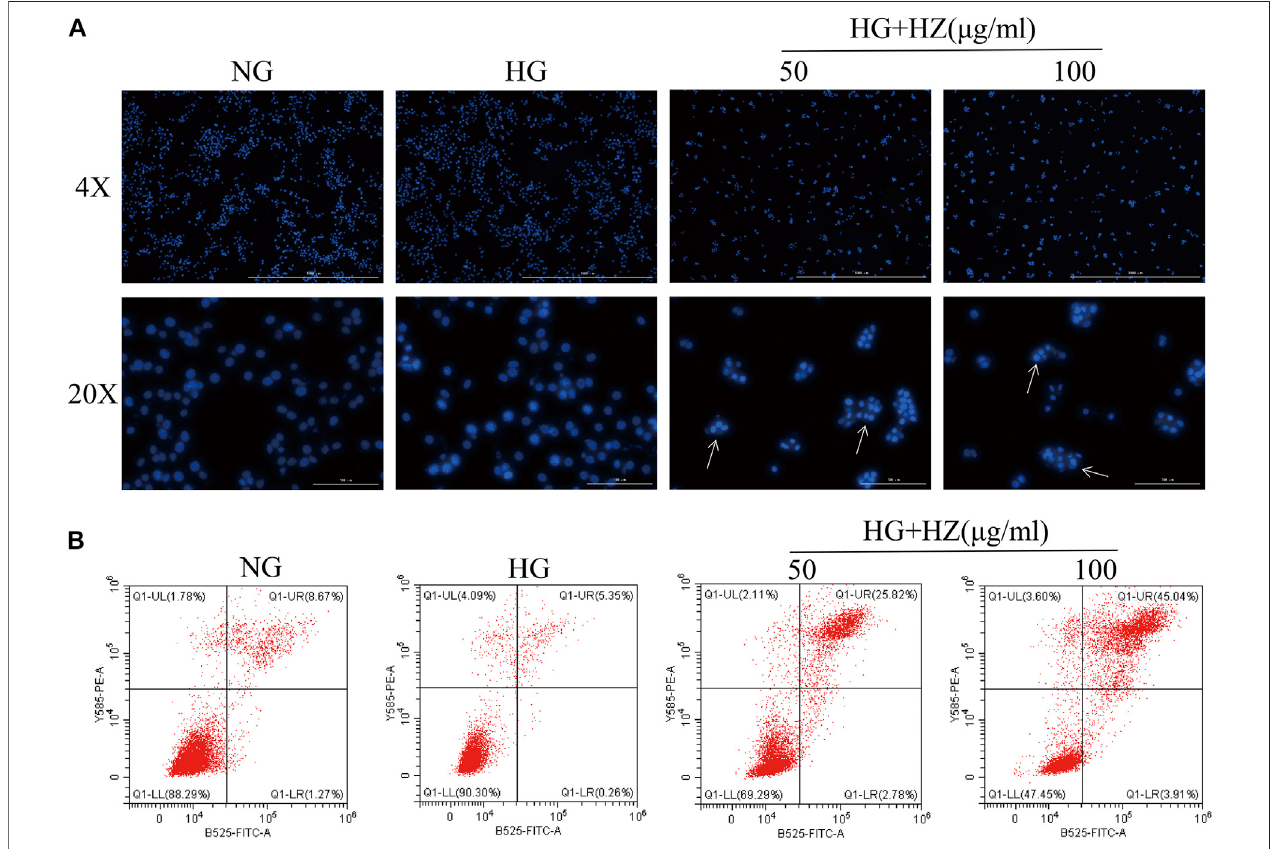
FIGURE 4 | Effect of HZQMY on cell apoptosis. (A) Effects of HZQMY on nuclear morphology in HRCECs exposed to high glucose. (B) Cell apoptosis was detected by fl ow cytometry. Magni fi cation, × 40 and × 200. HZ: HZQMY.